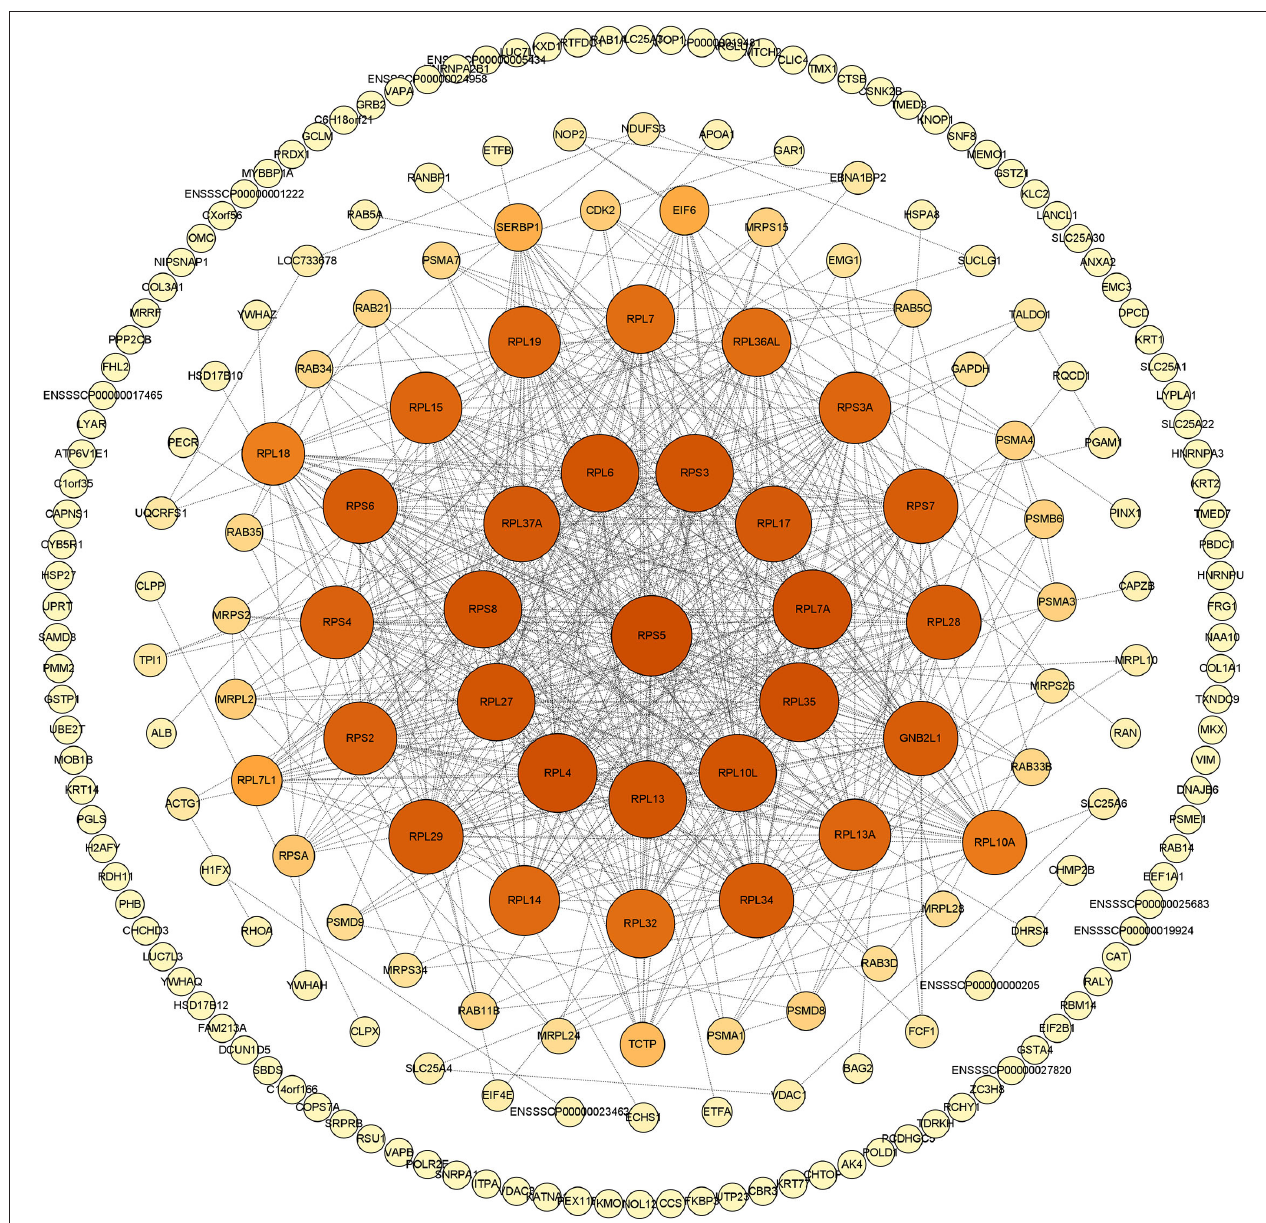
FIGURE 2 | The PPI network generated in this study. Construction and analysis of the protein-protein interaction (PPI) network using the STRING database. The network of swine acute diarrhea syndrome coronavirus (SADS-COV) M-interacting proteins interacting was constructed and plotted using the network analyzer tool, Cytoscape v.3.8.2. The nodes are identified host proteins, expressed as their respective NCBI gene names. Edges represent the interaction between nodes. The higher the degree, the larger the node and the darker the